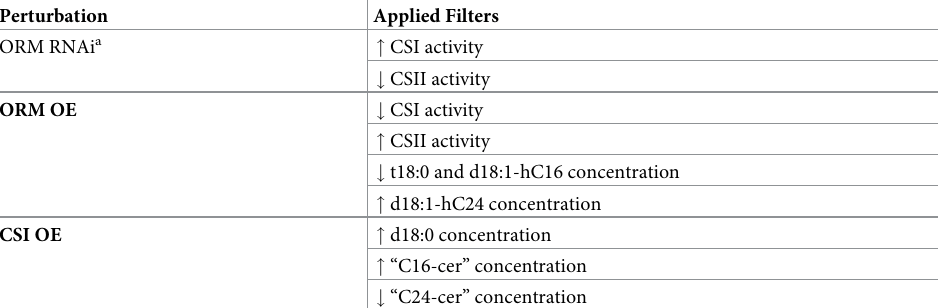
Table 2. List of perturbations and associated filtration steps used to screen the ensemble of